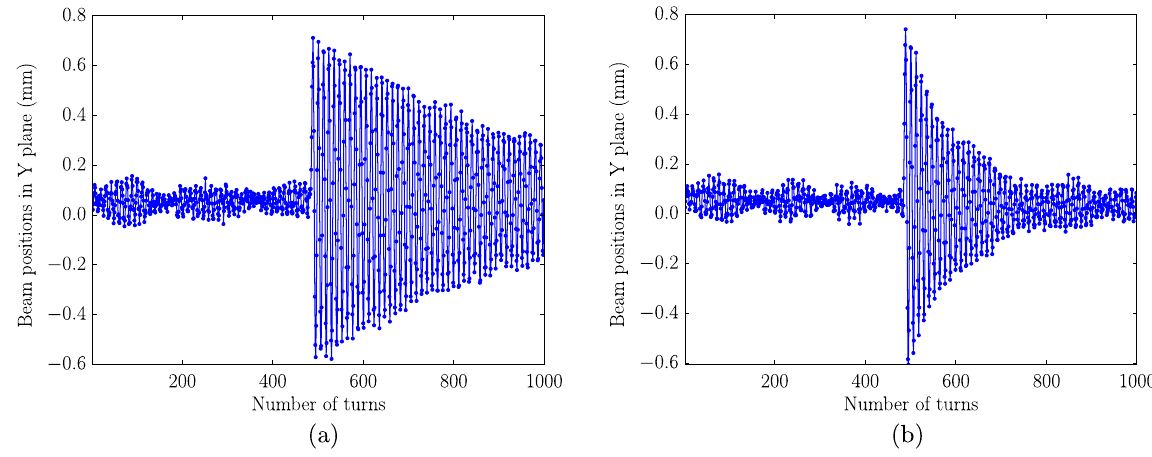
FIG. 15. Suppressing turn-by-turn orbit oscillations with the bunch-by-bunch damper in a test. The oscillation begins at turn 512 when the tune meter kicker excites the beam. (a) Without damper (b) With